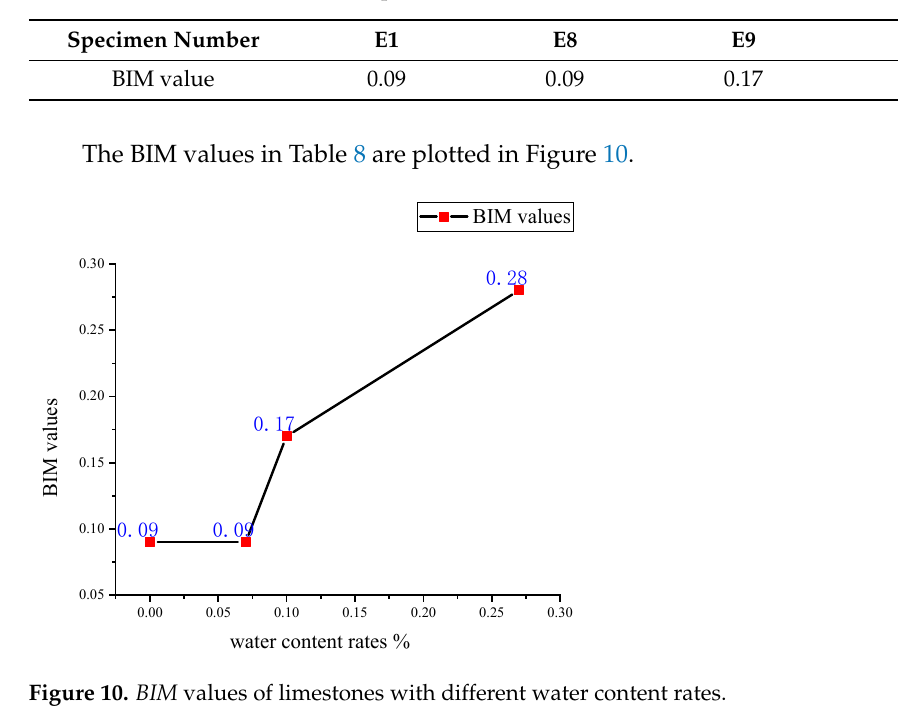
Table 8. The BIM value of each test piece.